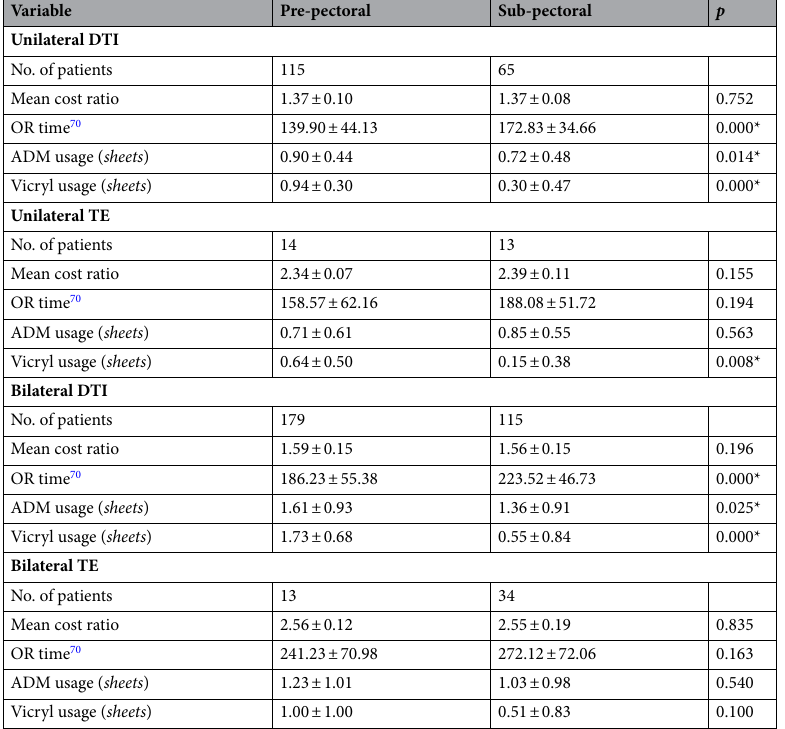
Table 6. Sub-group analysis by laterality and reconstruction staging. This table further describes the cost differences between sub-pectoral and pre-pectoral breast reconstruction by conducting analysis independent of both laterality and staging. None of the sub-group analyses found significant cost differences between sub-pectoral and pre-pectoral breast reconstruction. While differences in ADM usage, operative time, and Vicryl mesh usage remained in some of the sub-group comparisons. Continuous variables were analyzed via independent two-tailed t-tests (95% confidence interval) and displayed with standard deviation values. Cost ratio: a given cost value divided by the base procedural cost of unilateral direct-to-implant reconstruction. DTI direct-to-implant, TE tissue expander; ± SD; 95% CI. Values for ADM (acellular dermal matrix) or Vicryl mesh are averages across all patients in each group. OR time is measured as procedure start to end time in minutes. *Statistically significant ( p <